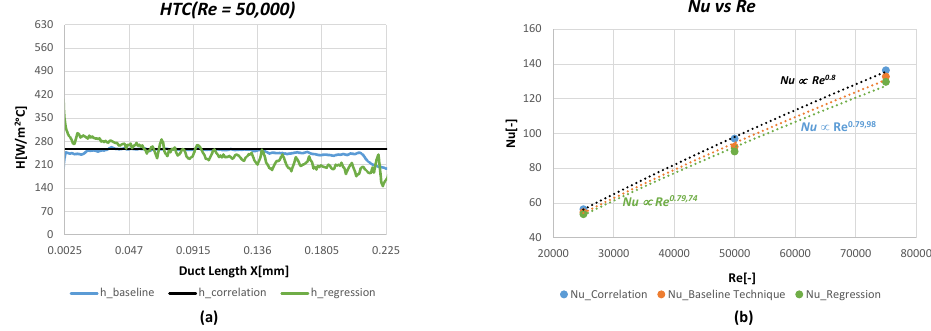
Figure 4. Heat transfer coefficient (HTC) comparison for Re = 50,000 (cid:48)(cid:48) ( a ) Nu vs. Re ( b